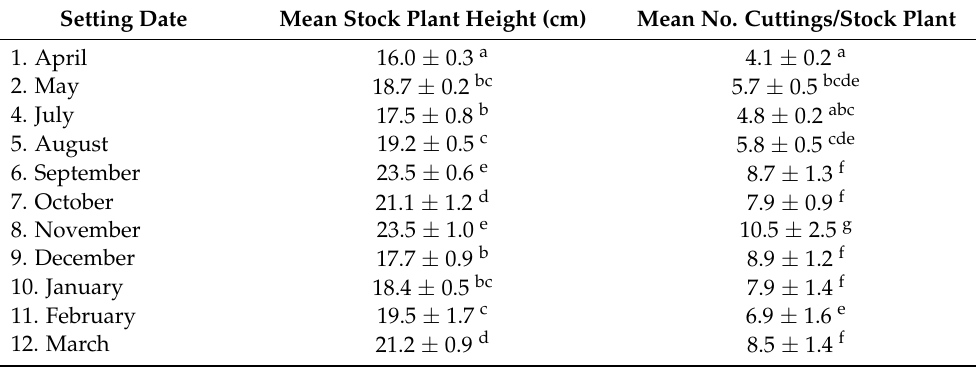
Table A2. Setting date means (i.e., data pooled across densities) for stock plant height before the collection of mini cuttings and stock plant productivity (mean number of mini cuttings per stock plant) for potting mix. Means followed by the same letter show no significance at the 95% confidence